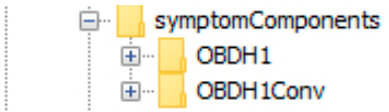
Figure 26. The symptom components OBDH1 and OBDH1Conv corresponding to the detected discrepancies listed in the diagnosis.xml-file.